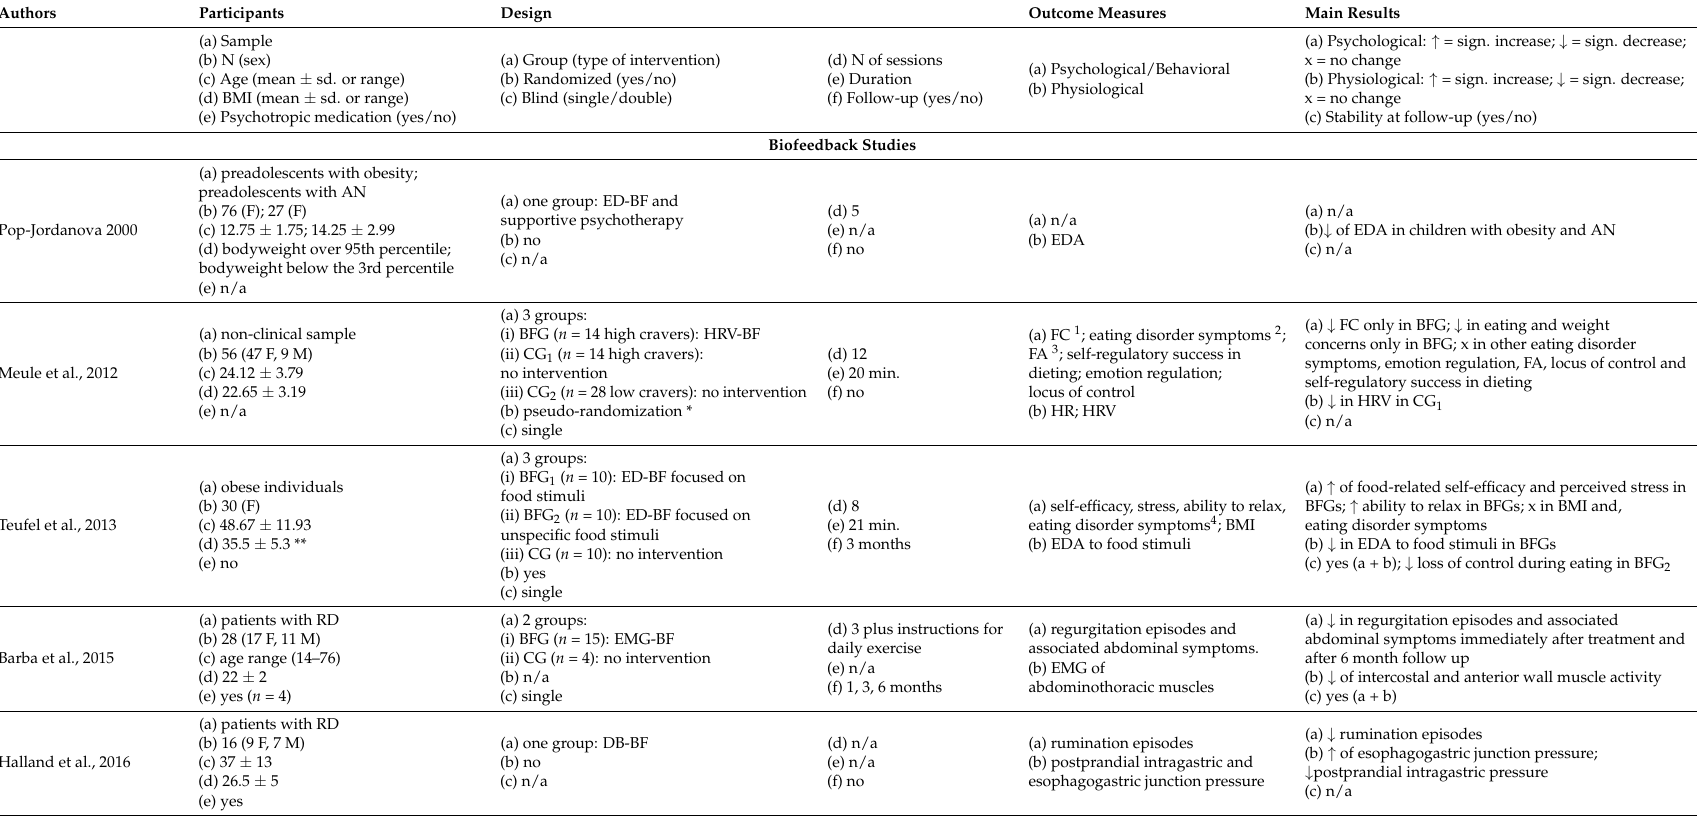
Table 1. Characteristics of the included studies ( n =